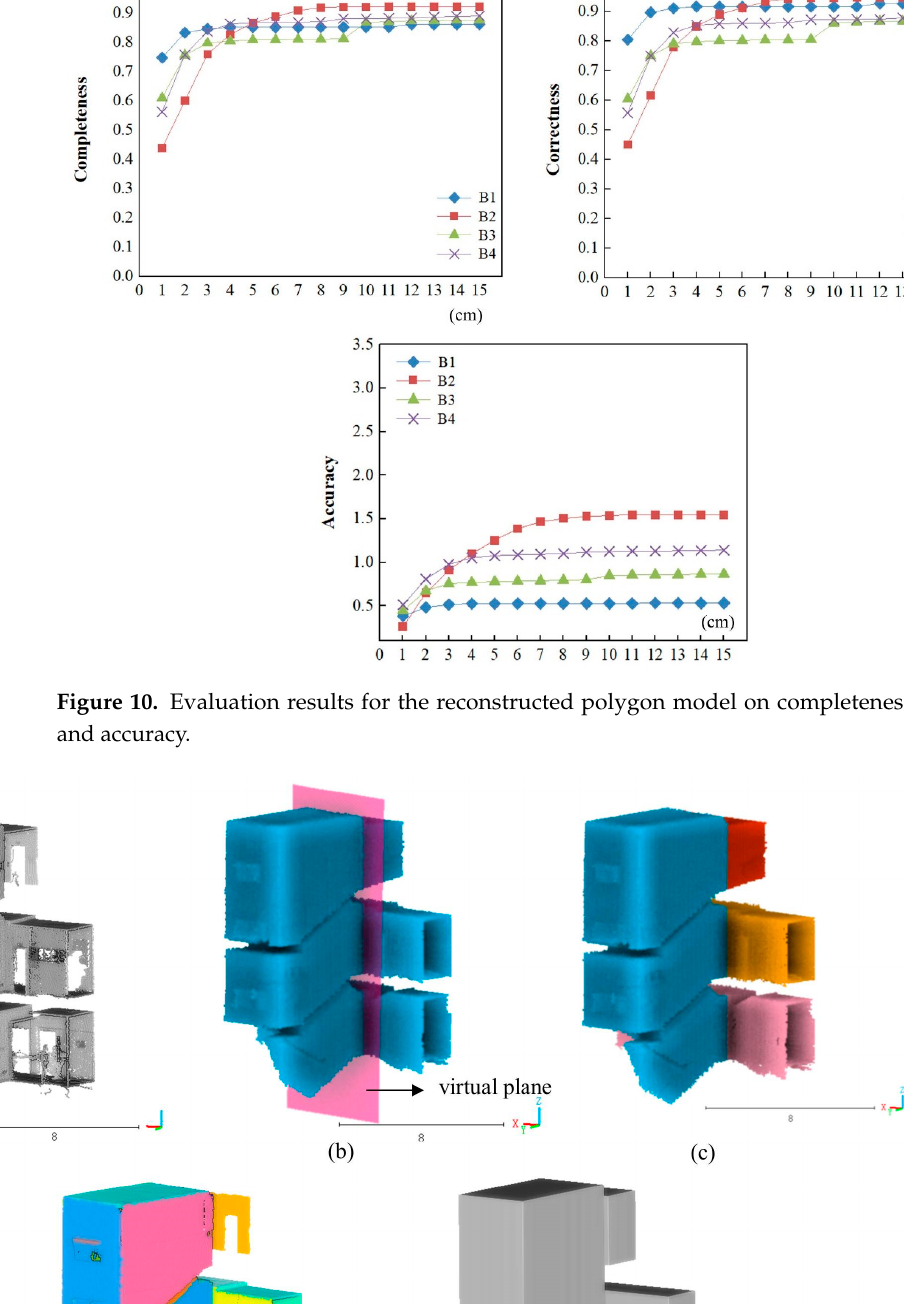
Figure 12. ( a ) Original point cloud; ( b ) reconstructed room layout of cross-floor space, where too many small pieces of subspaces result in defects in the result model.